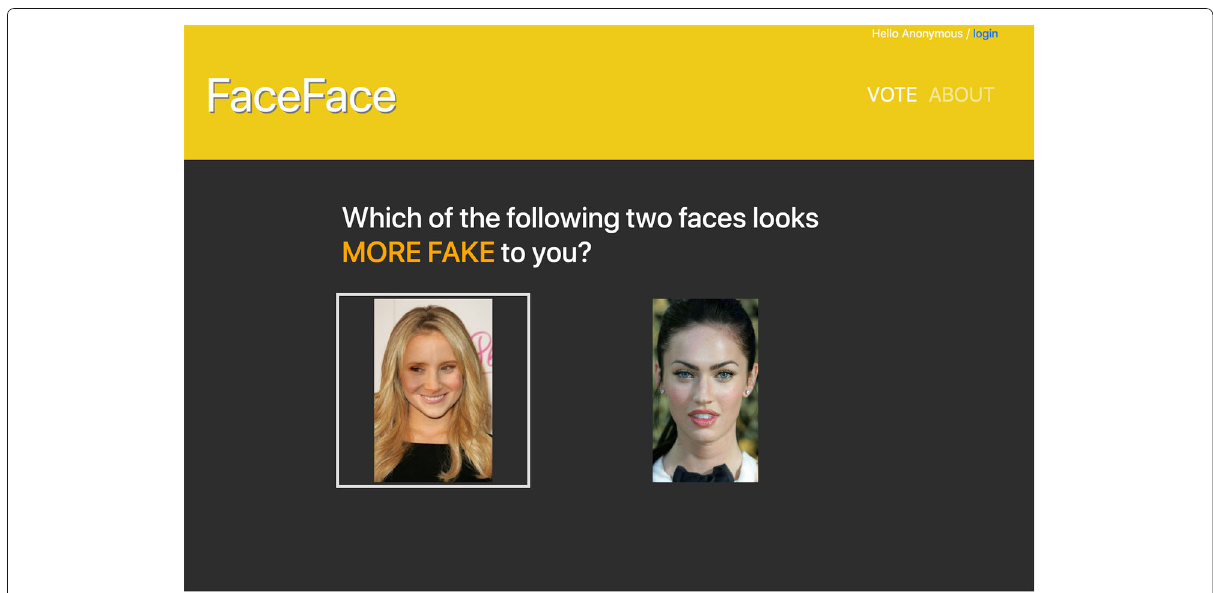
Fig. 2 A screenshot of the website collecting pairwise comparisons. As the mouse hovers over the left image, it is highlighted